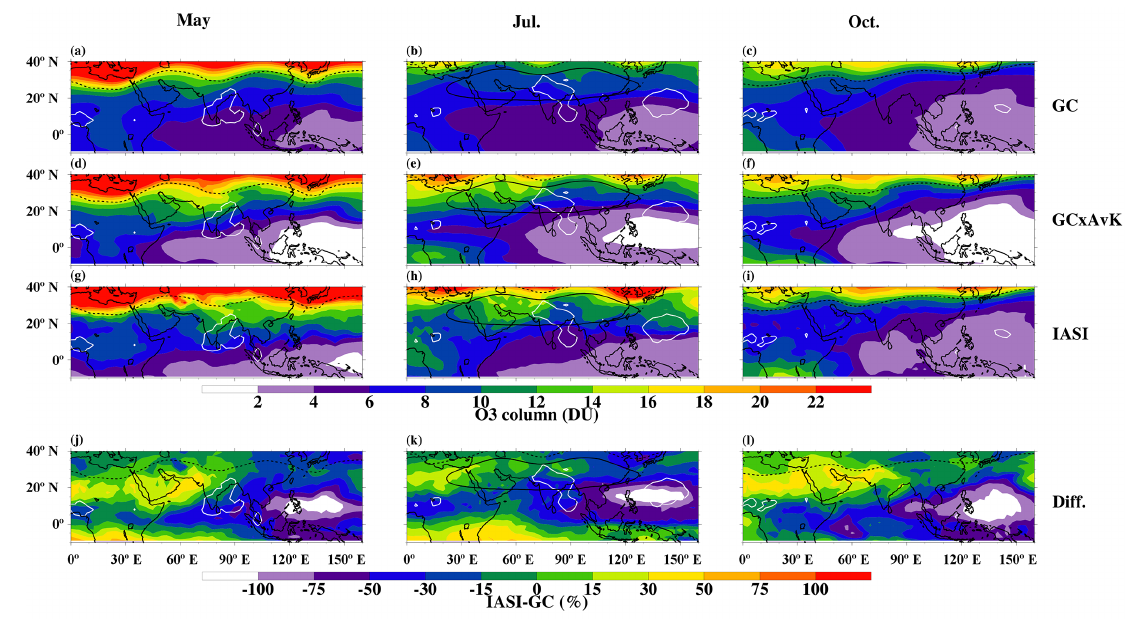
Figure 5. Same as Fig. 1 for O 3